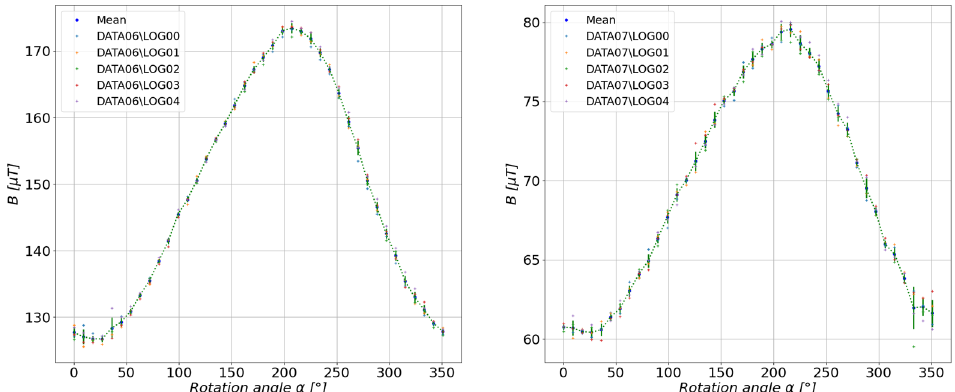
Figure 14. Measurement results at a distance of 12 cm ( left ) and 15 cm ( right ) from the center of the tested configuration.